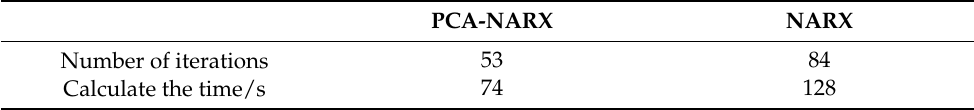
Table 3. Summary calculated rate of before and after